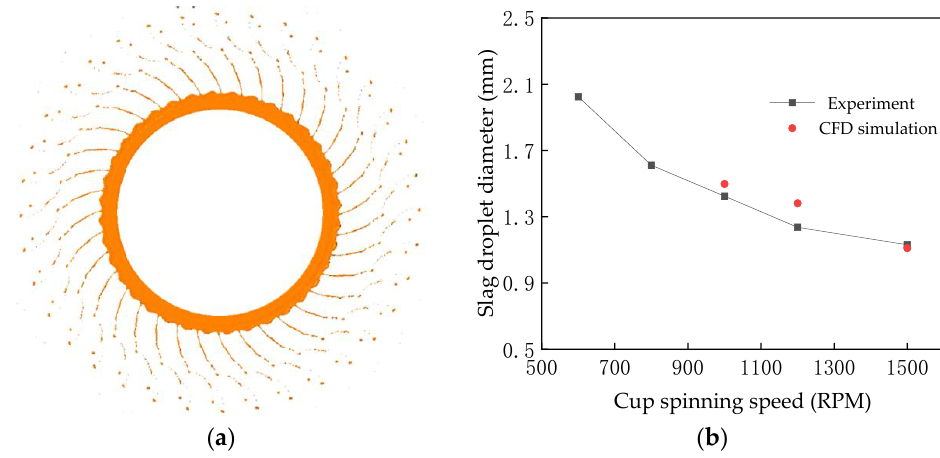
Figure 4. Comparison of CFD simulation results with experimental measurements reported in the literature. ( a ) CFD model simulated breakup process of molten slag with a spinning cup. ( b ) Comparison of slag droplet diameter predicted by CFD model and those measured in experiment [25].